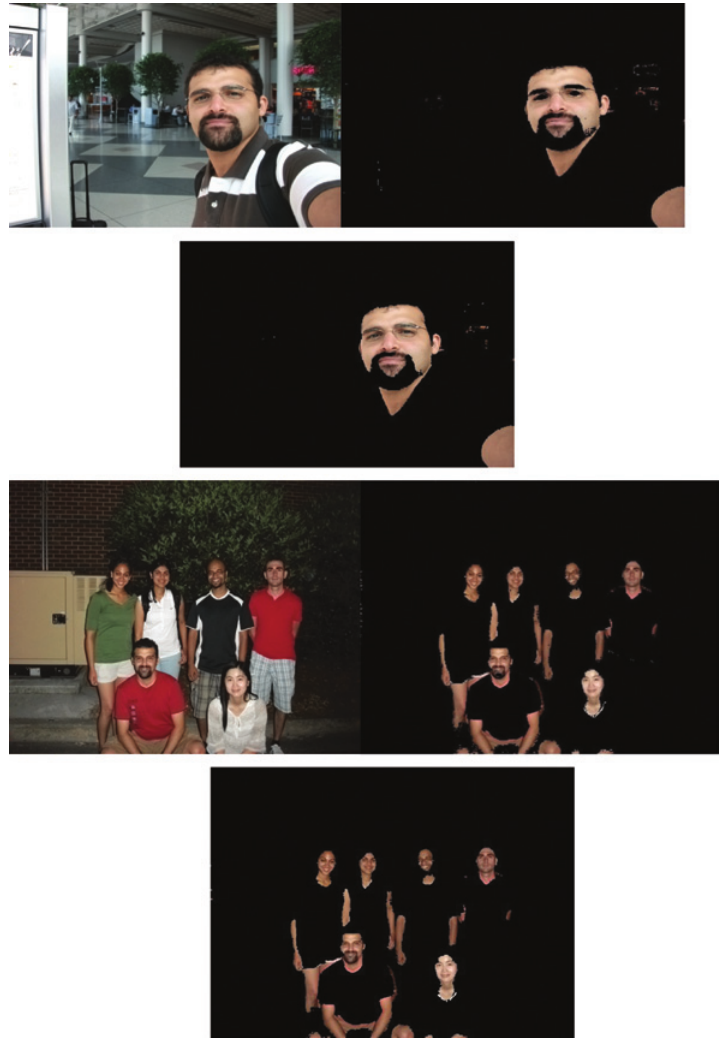
Figure 6. Experimental Results on the VT-AAST